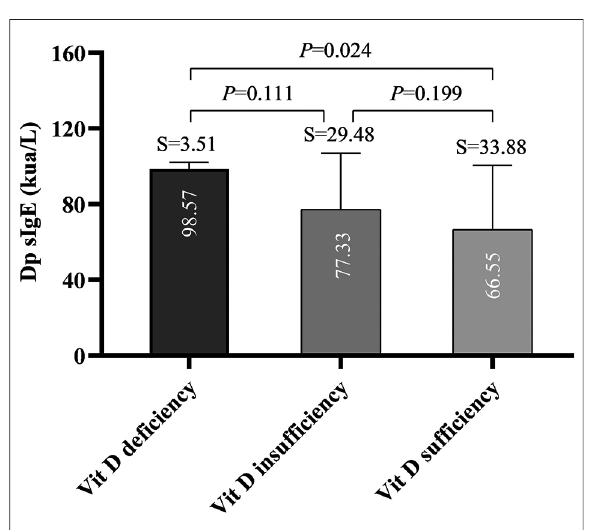
FIGURE 3 Medication scores before and after AIT.